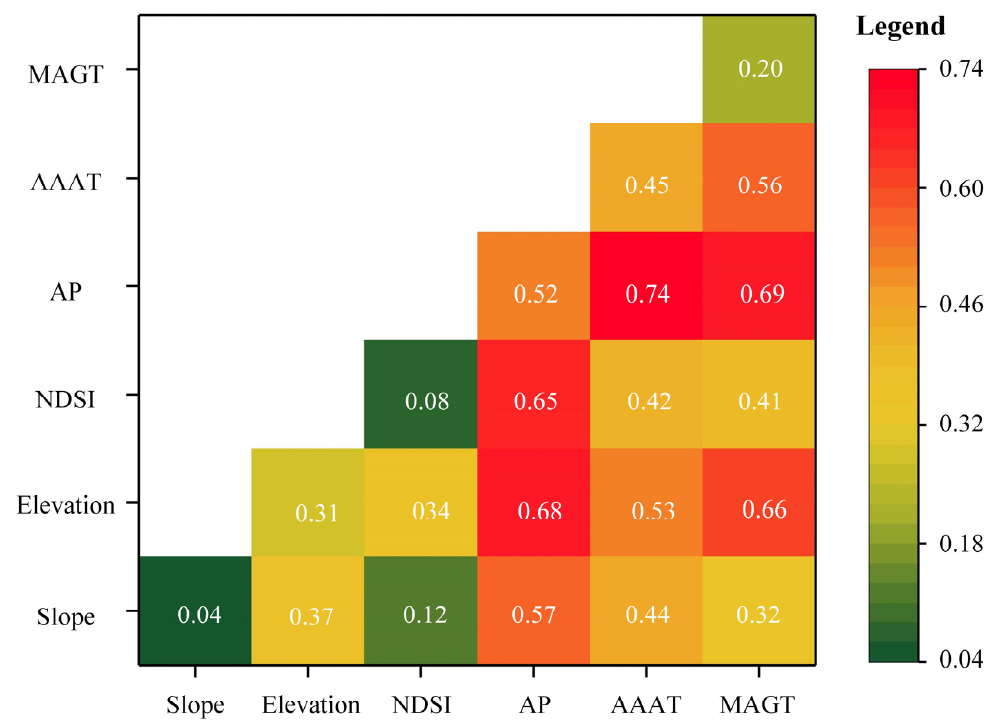
Figure 5. Effects of two interactive factors on Normalized Difference Vegetation Index (NDVI) along the National Highway G214 from the Changshitoushan Mountain Pass to Qingshui’he Riverside at the northern and southern flanks of the Bayan Har Mountains, southern Qinghai, China, from 2010– 2019. Note: NDSI, Normalized Difference Snow Index; AP, annual precipitation; AAAT, average annual air temperature; MAGT, mean annual ground